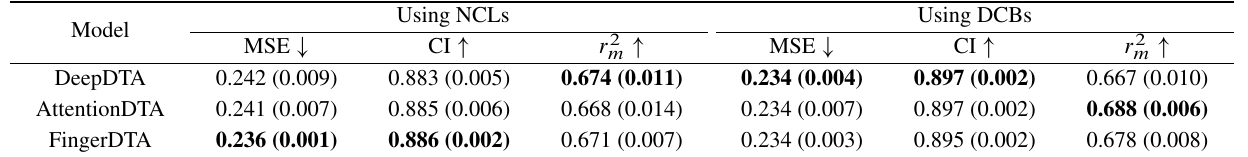
Fig. 6 Example of slice similarity distribution of the same domain. Table 4 Ablation results on the testing data of the Davis data set.